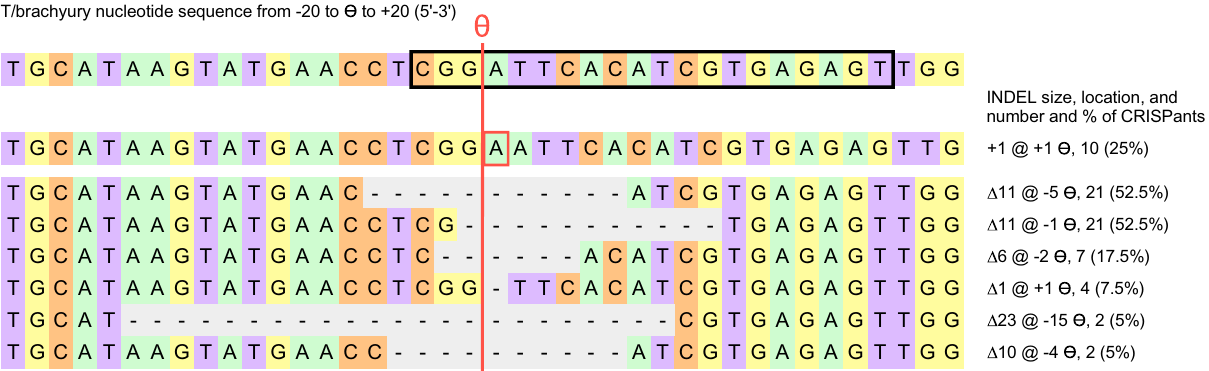
Figure 6. INDELS with occurrence in more than one individual. The sequence around ϴ is shown, for 20 bp on either side. The black box frames the sequence complementary to the targeting portion of the single-guide RNA. The position of the cut site ϴ is indicated by the vertical red line. Only one insertion was detected, the addition of an A, which was present in 10 independent CRISPants. Deletions that were found in 2 or more individuals are listed in descending order of frequency; 10 individual CRISPants had both 11 bp